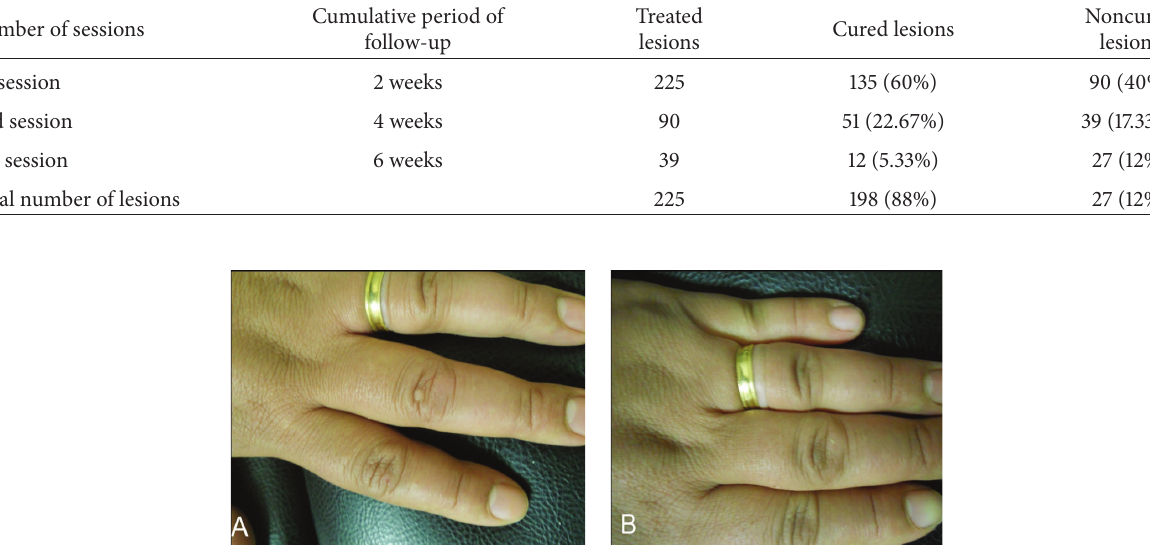
Figure 1: Female patient 34 years old with common wart on the dorsum of middle finger of left hand treated with intralesional injection of 2% zinc sulfate with complete cure (A) before treatment and (B) after